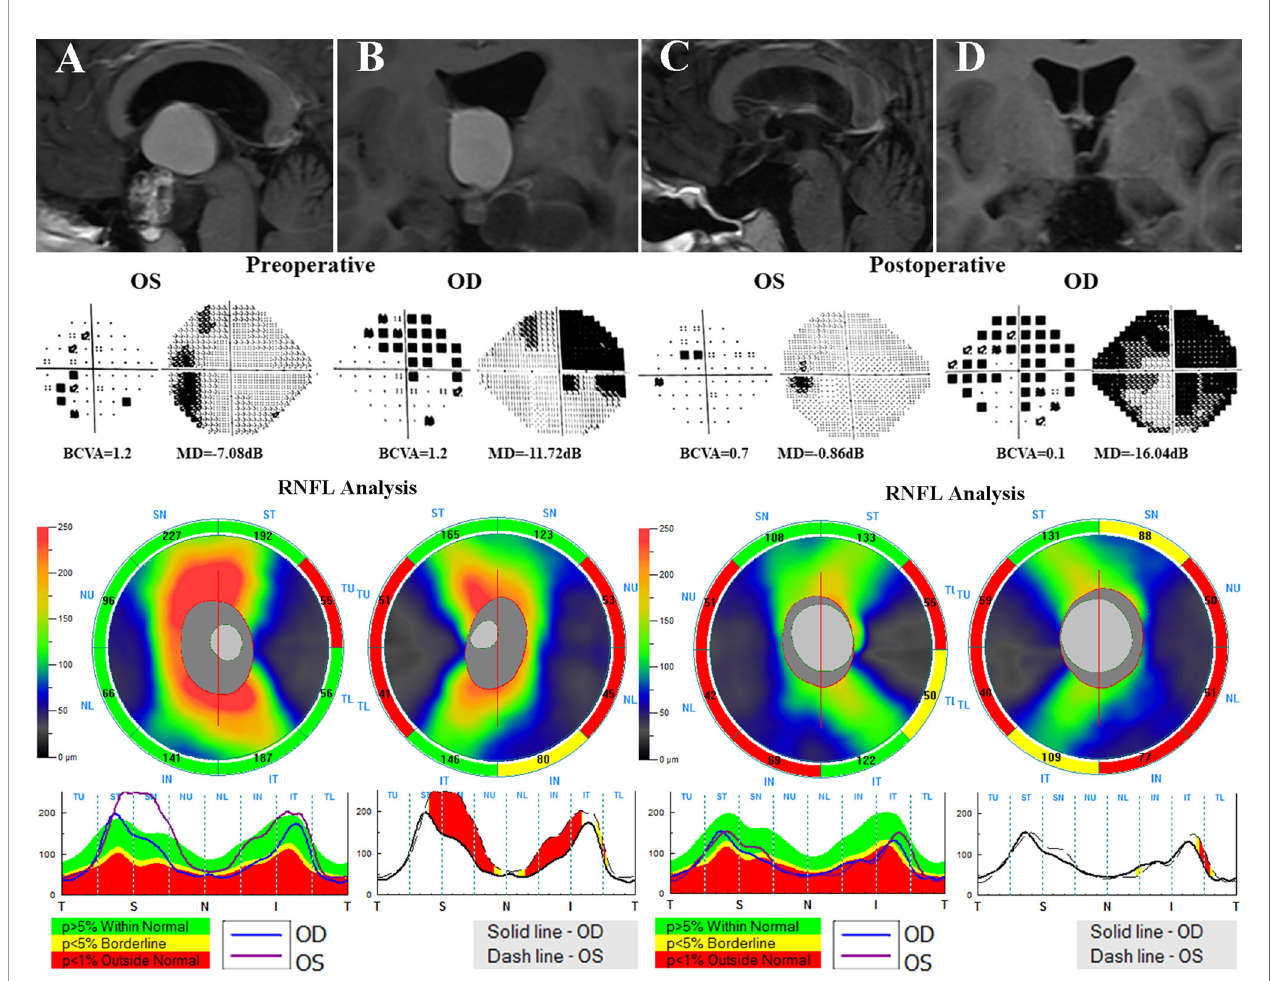
FIGURE 5 | A 21-year-old male who underwent endoscopic surgery for craniopharyngiomas was evaluated before and after surgery. Preoperative MRI scans (A, B) reveals a suprasellar cystic-solid tumor involving the third ventricle compressing the optic chiasma. Preoperative visual fi eld examination suggested bitemporal VF defects. Preoperative OCT showed decreased temporal cpRNFL thickness in both eyes and inferior cpRNFL thinning in the right eye. After surgery (C, D) , the deterioration of VA in both eyes and VF in the right eye were observed. OCT, optical coherence tomography; cpRNF, circumpapillary retinal nerve fi ber layer; BCVA, best-corrected visual acuity; MD, mean deviation; VA, visual acuity; VF, visual fi